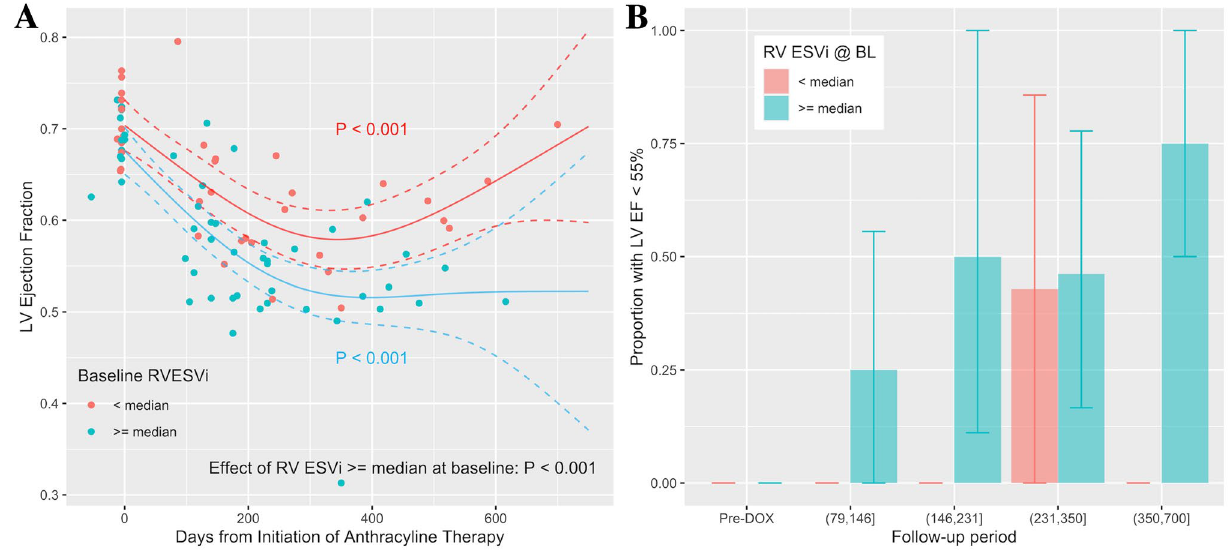
Figure 4. Predictors of LV systolic dysfunction post-anthracycline: ( A ) LVEF was within the normal range in all patients at baseline and declined significantly after anthracycline therapy ( P < 0.001). After anthracyclines, LVEF was significantly lower in patients with higher than median RV ESVi at baseline compared to in patients with an RV ESV index < its median (55%) at baseline (BL). The solid lines represent cubic regression splines for the time from anthracycline therapy initiation, which were estimated with a generalized additive model (GAM) with mixed effects. The model also included RV ESVi at baseline as independent predictor. The effect of an above median RV ESVi at baseline remained significant ( P < 0.001) when LV ESVi at baseline was added to the model. ( B) The bar graph presents an analysis complementary to A for the proportion of patients with LVEF < 55% during follow-up periods. LV EF < 55% was significantly more frequent during follow-up if RV ESV index ≥ median at baseline—the final follow-up period from > 350 to 700 days, the proportion reached 75% percent. At baseline, all patients with RV ESVi < median had an LVEF within the normal range. The error bars denote the 95% confidence intervals and were generated by the bootstrap method with sampling by patient